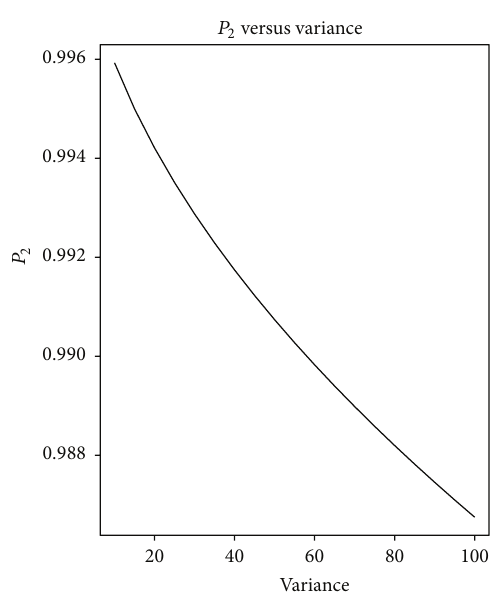
Figure 6: 𝑃 2 against variance based on log-transformed